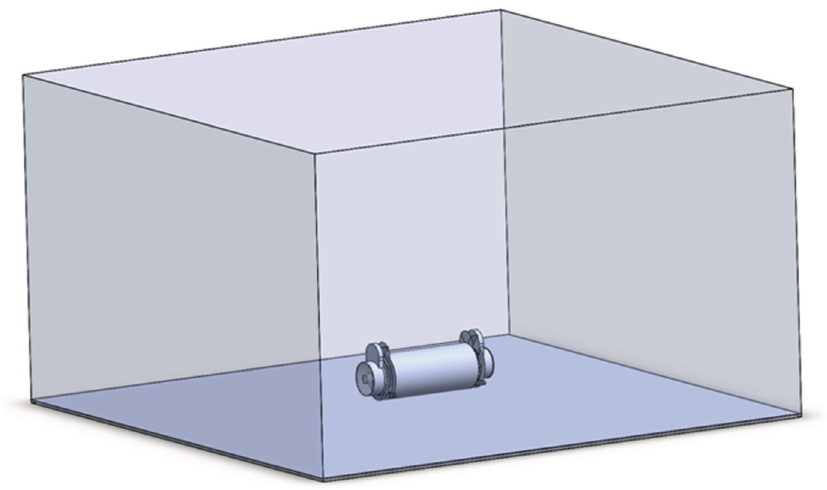
Figure 5. CFD simulation domain for numerical analysis of the air flow generated by the